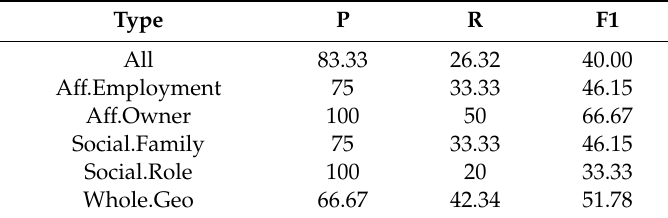
Table 17. Accuracy of relation extraction when using only word features F wc for specific relation